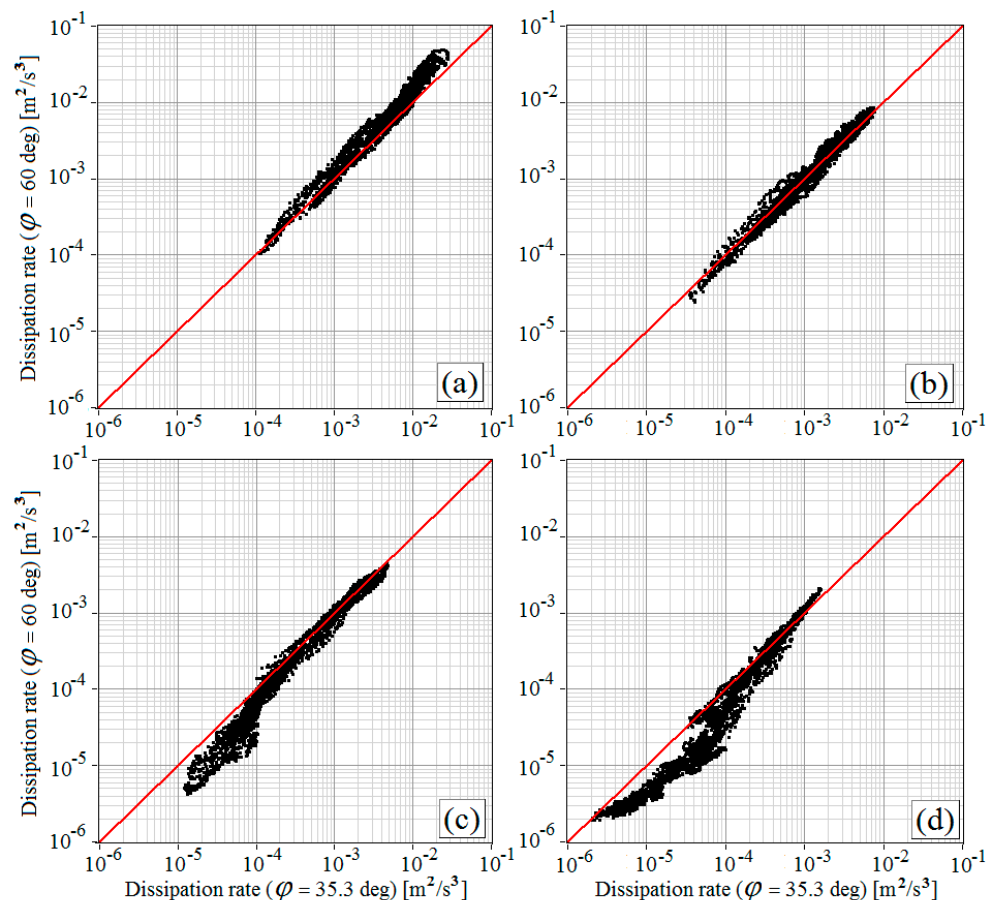
Figure 5. Comparison of estimates of the turbulent energy dissipation rate (black dots) obtained from measurements by the lidar at elevation angles of 35.3° and 60° from 20:00 LT on 23 July to 08:00 LT on 24 July 2018 in the vertical layers of ( a ) 100–200, ( b ) 200–300, ( c ) 300–400, and ( d ) 400–500 m. Each estimate of the dissipation rate was obtained from data of 20 conical scans.